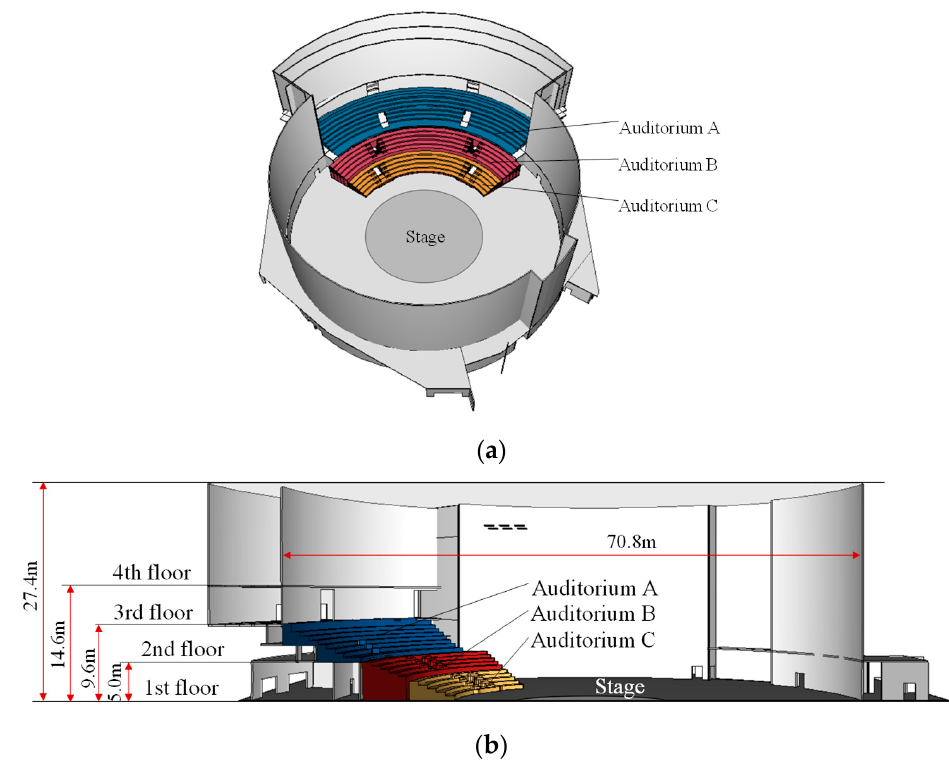
Figure 1. Theater model diagram. ( a ) 3D model of the theater; ( b ) a section view.